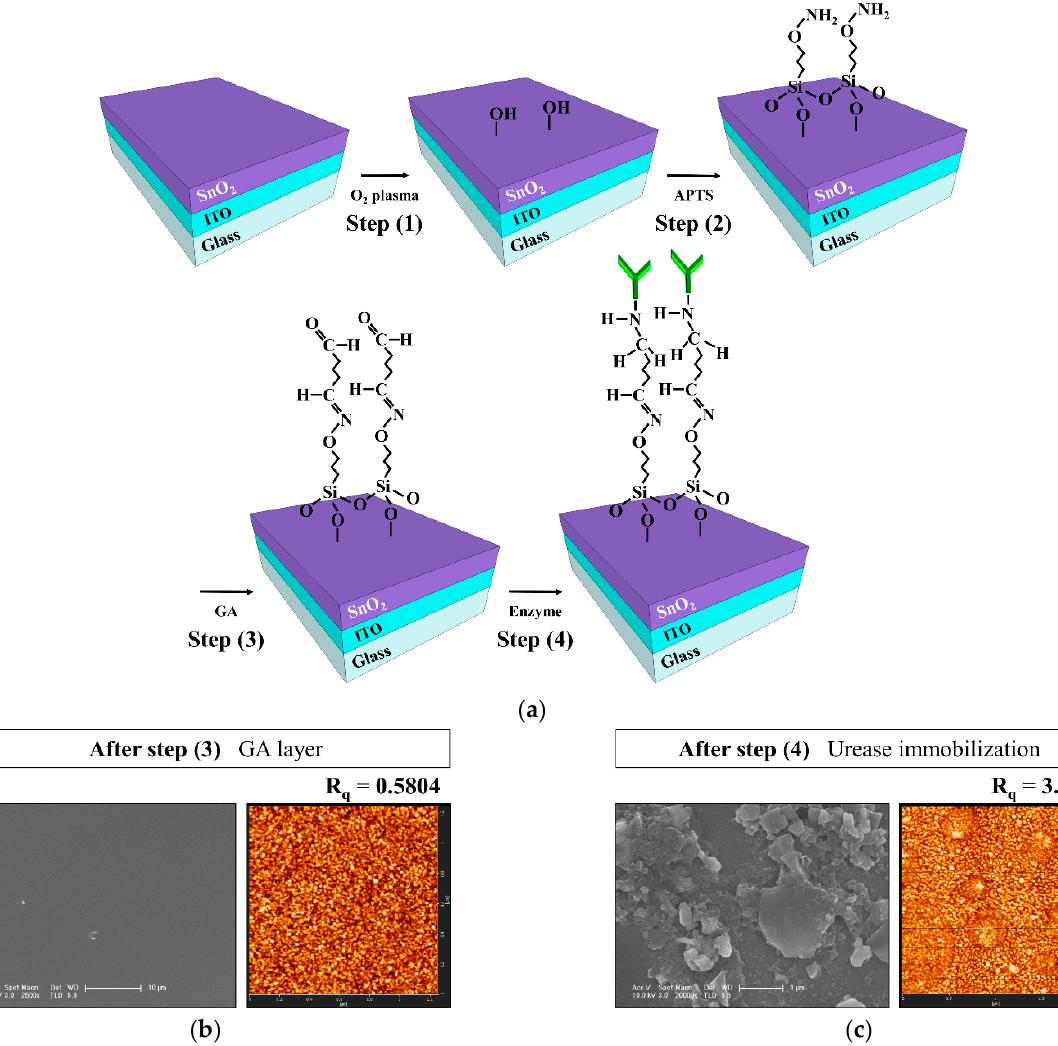
Figure 3. ( a ) Schematic diagram of the covalent bond process on the SnO 2 sensing membrane of the EG. SEM and AFM images of the SnO 2 membrane surface after ( b ) Step 3 (GA) and ( c ) Step 4 (immobilization of the urease